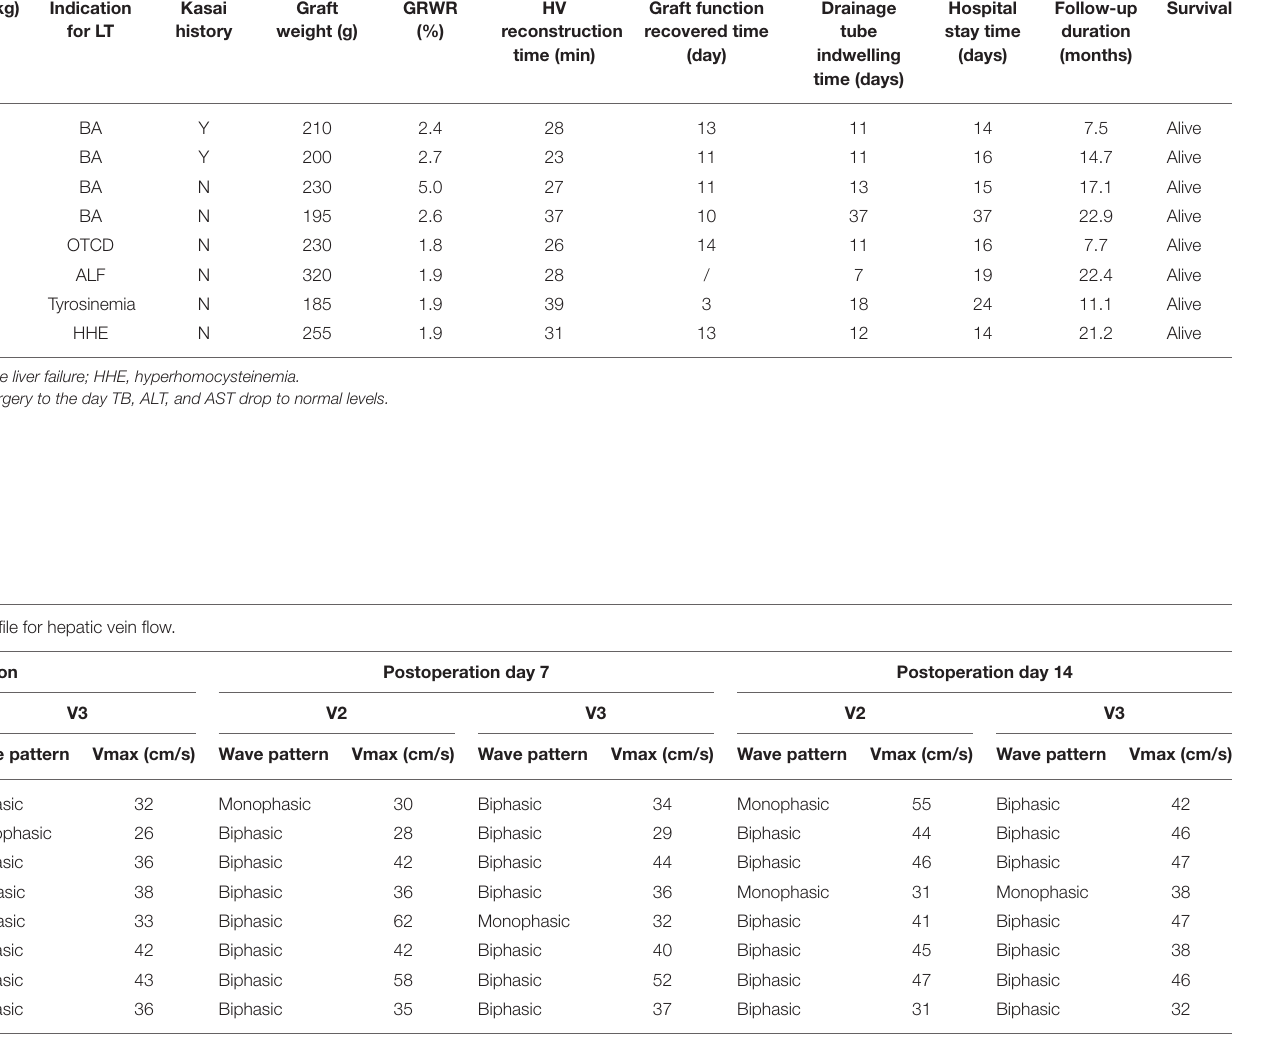
TABLE 2 | Individual information for each patient receiving modified dual HV anastomosis. Patient